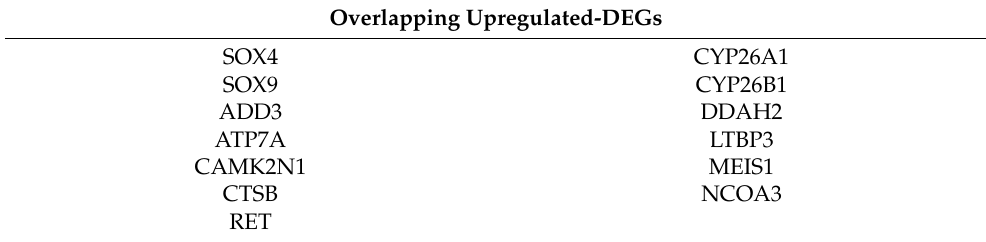
Table 1. Overlapping upregulated DEGs of the four datasets from GEO.